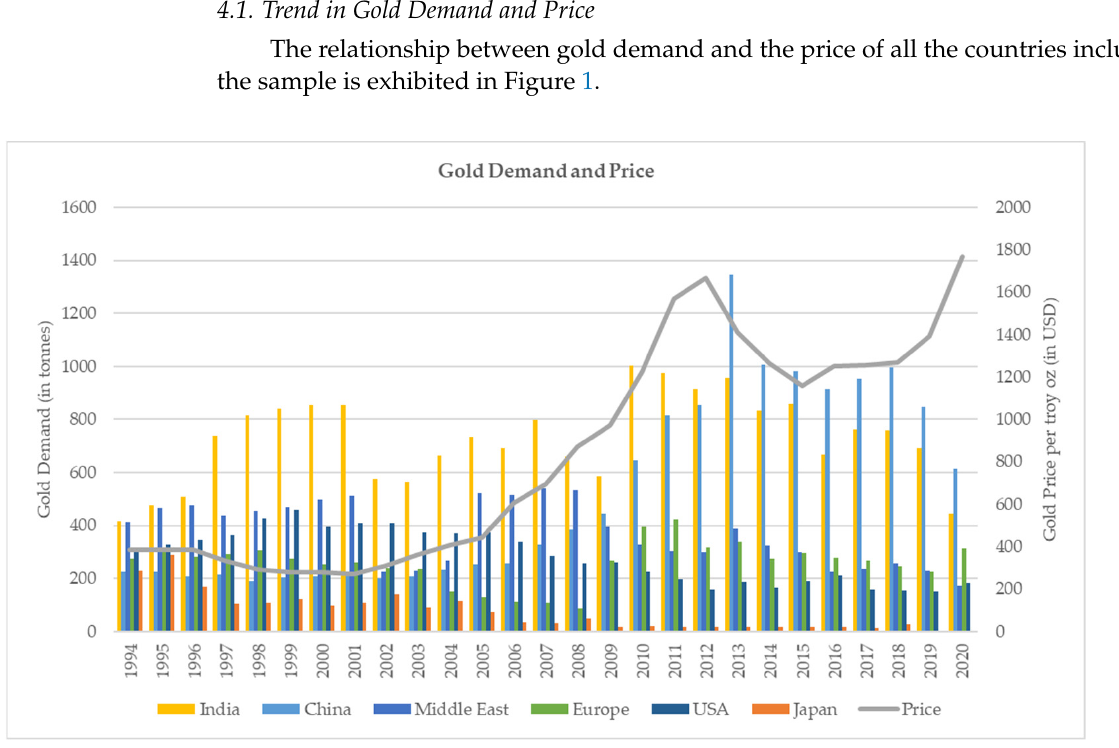
Figure 1. International gold price and demand trend.